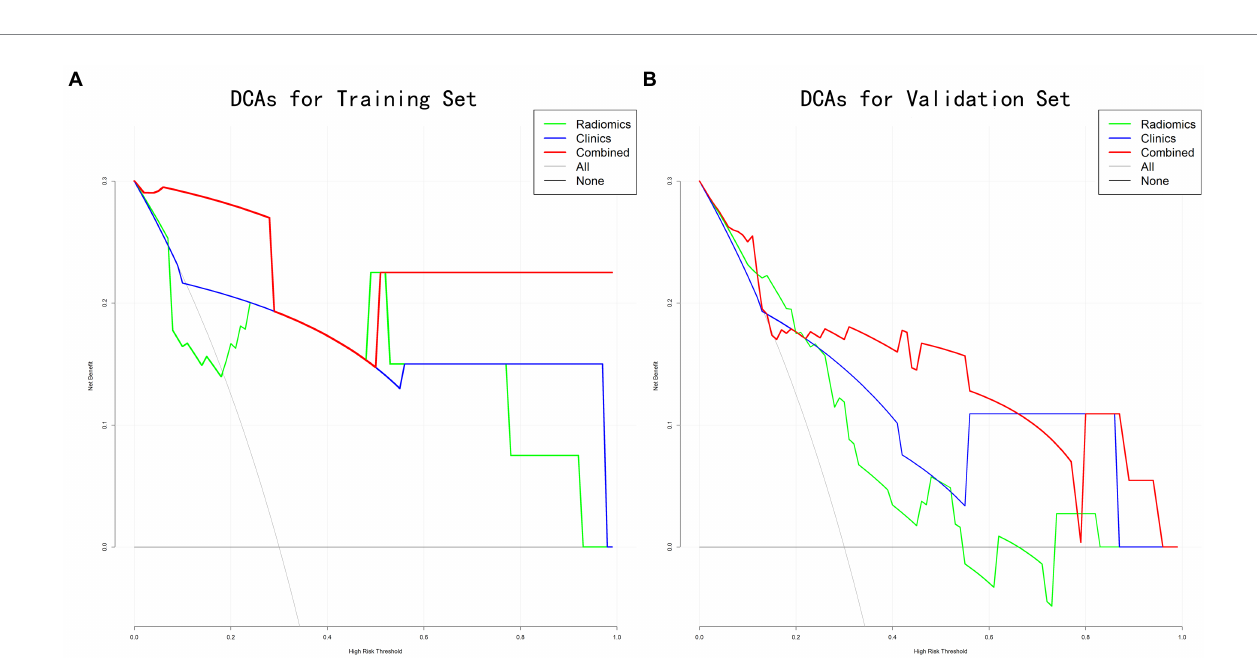
FIGURE 4 Decision curve analysis presenting the predictions of the radiomics, clinical, and combined models. (A) The training set; (B) the validation set. The threshold probability and net benefit are presented by x -axis and y -axis, respectively. The variance between the expected benefit and expected harm of the decision serves as a representation of the net benefit. The decision curve indicated that, in contrast to the other models, the combined model provided a higher net